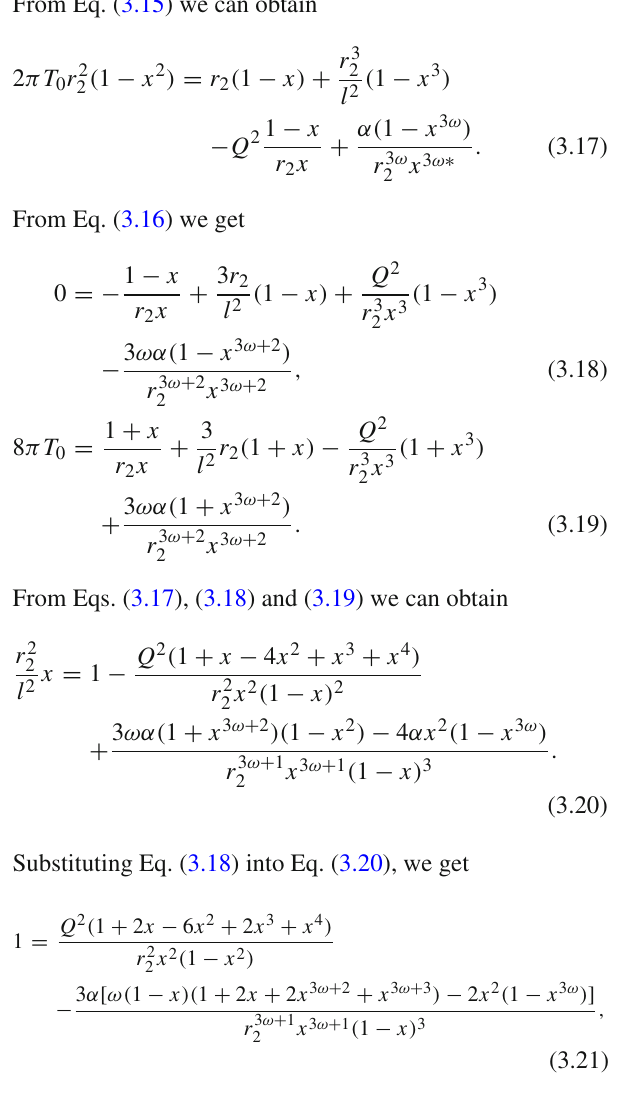
From Eq. (3.15) we can